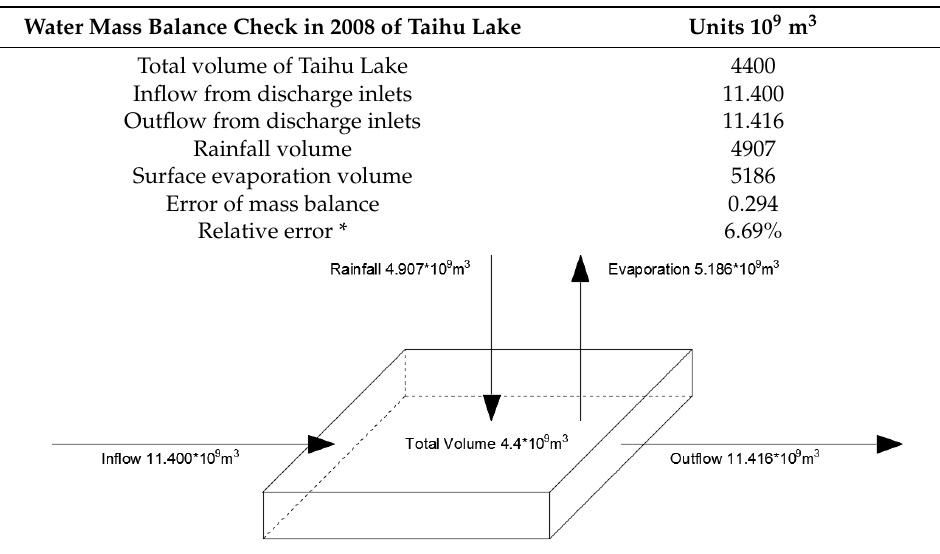
Table 1. Mass balance check using a box model.